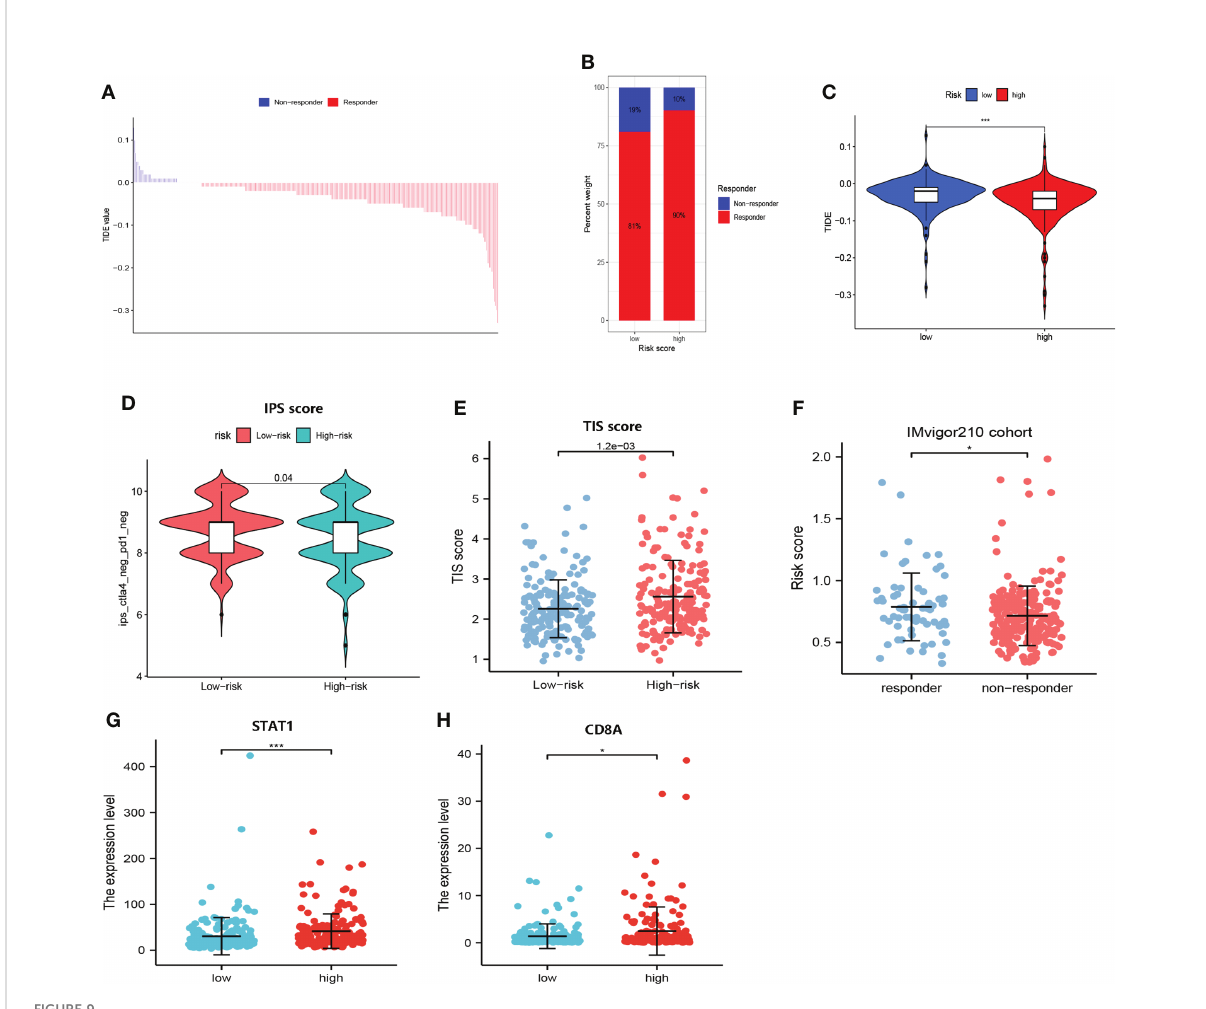
FIGURE 9 Responses of immunologic therapy. (A) The distribution of the TIDE score in responders and non-responders. (B) The proportion of responders and non-responders in the high- and low- risk groups, respectively. (C) Comparison of the TIDE score in high- and low-risk groups. (D) Comparison of the IPS score in high- and low-risk groups. (E) Comparison of the TIS score in high- and low-risk groups. (F) Comparison of risk scores in responders and non-responders to immunotherapy in the IMvigor210 cohort. (G) Comparison of the expression level of STAT1 in high- and low-risk groups. (H) Comparison of the expression level of CD8A in high- and low-risk groups. (* and *** represent p < 0.05 and p < 0.001,